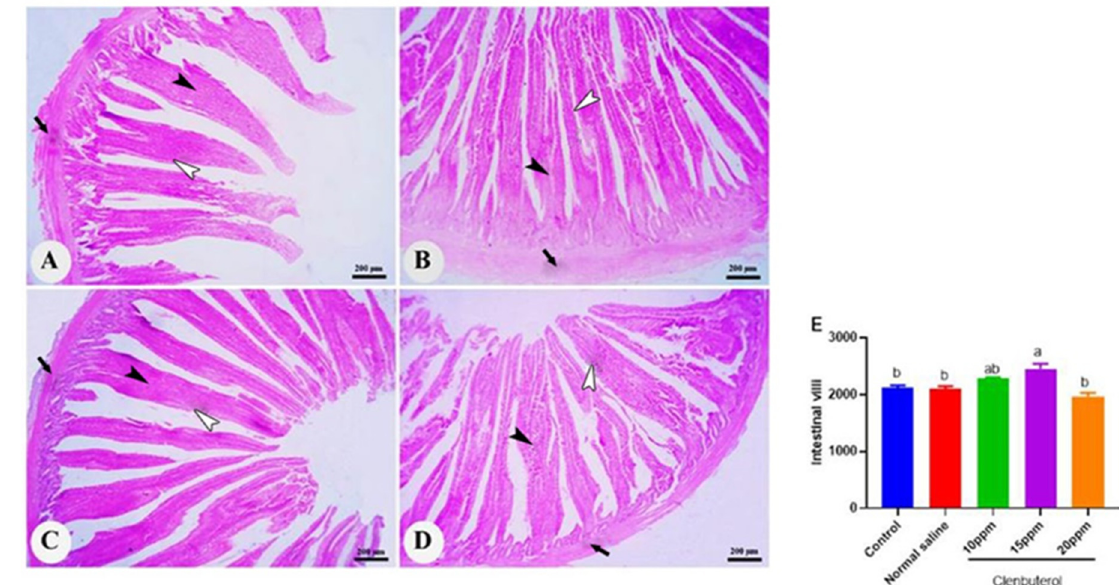
Figure 3. Photomicrograph of duodenum of control ( A ) and clenbuterol treated groups of chickens; ( B ) clenbuterol 10 ppm, ( C ) clenbuterol 15 ppm and ( D ) clenbuterol 20ppm showing intestinal villi composed of simple columnar epithelium (white arrow heads), connective tissue core (black arrow heads) of lamina propria and lamina muscularis (black arrows). Stain H&E, scale bar= 200 µ m. ( E ) morphometric analysis of duodenal villi length. Columns with differ superscripts (a, b) differ significantly ( p < 0.05).